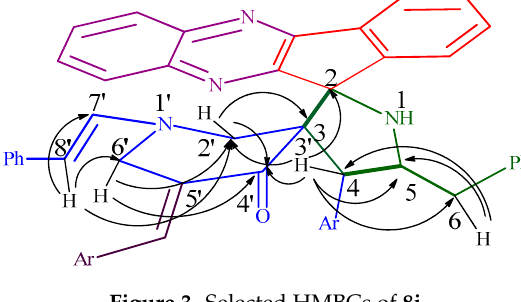
Figure 3. Selected HMBCs of 8j.